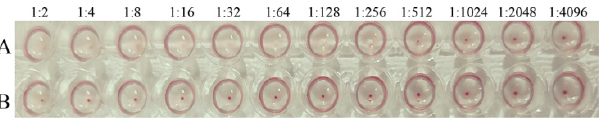
Figure 4. The hemagglutination test of PPV-VLPs. ( A ) Hemagglutination titer of the purified PPV- VLPs. ( B ) The negative